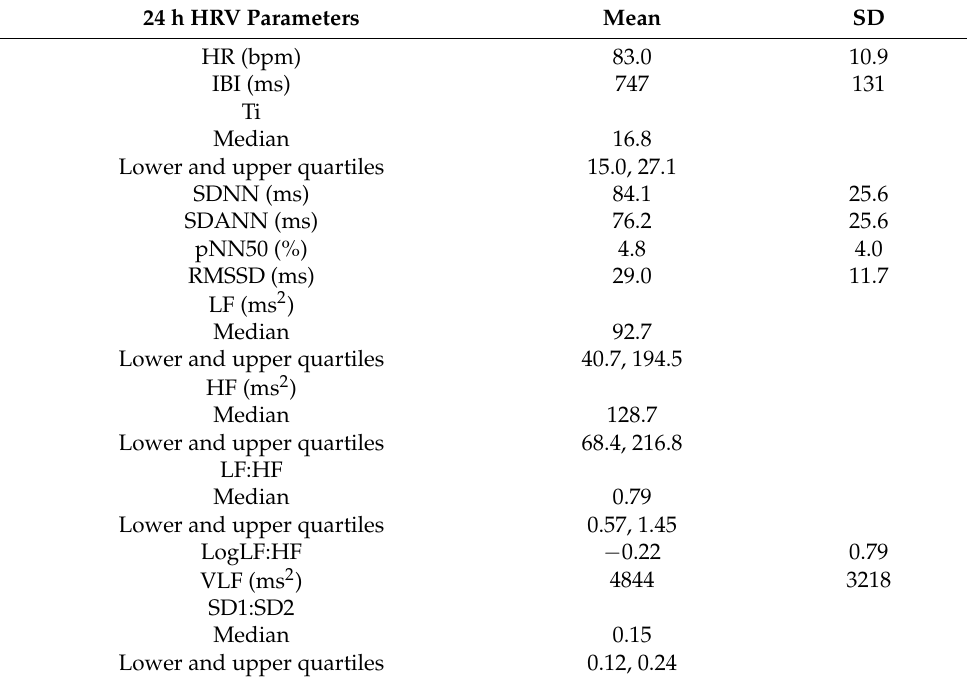
Table A1. 24 h HRV measurements in the study participants with analysable records (n =